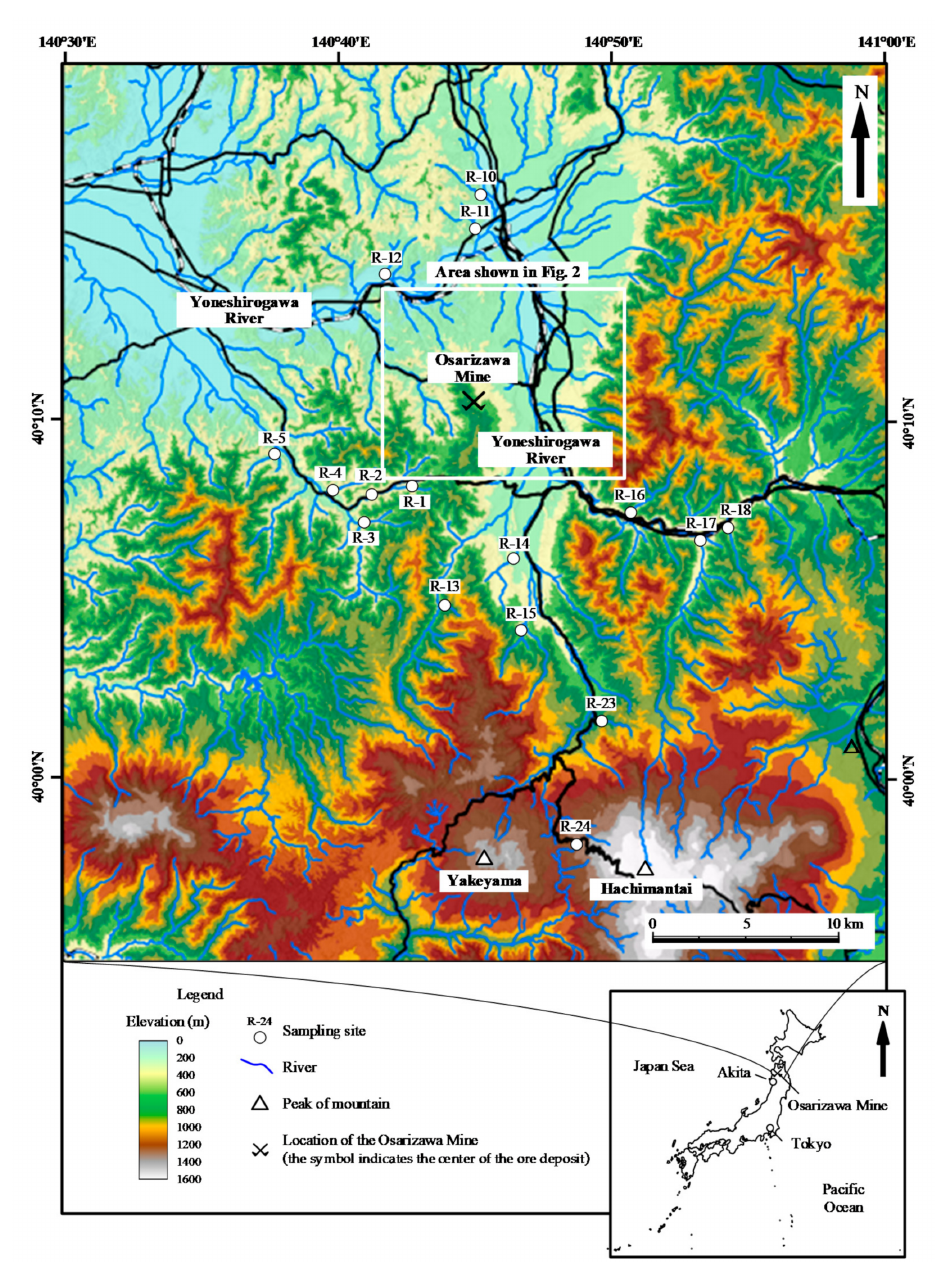
Figure 1. Topographic map of the study area showing the locations of water sampling points. The inset shows the location of the mine area in